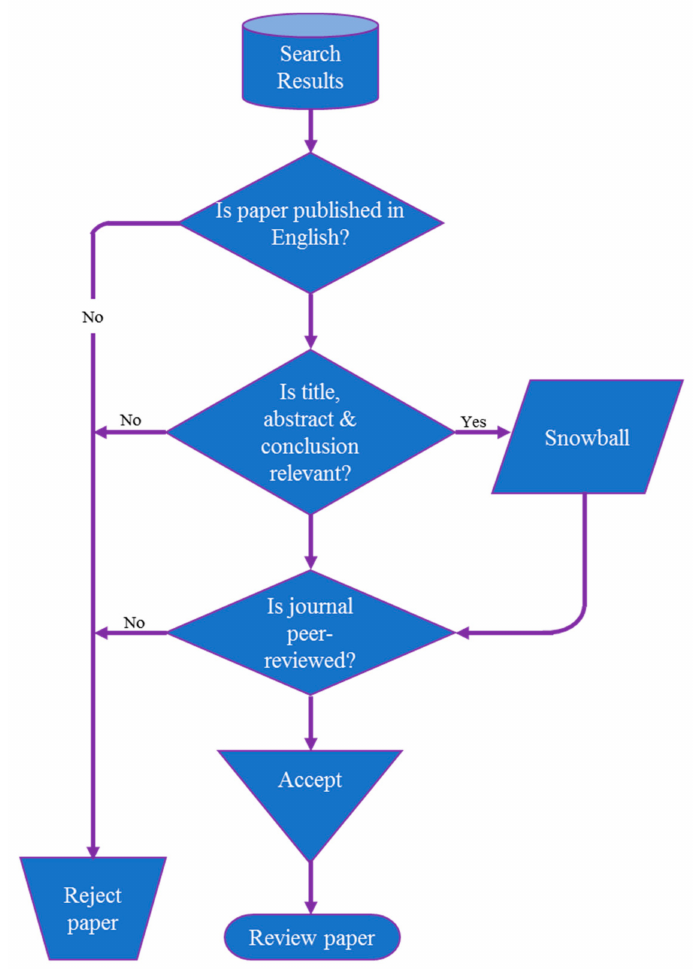
Figure 2. Review process